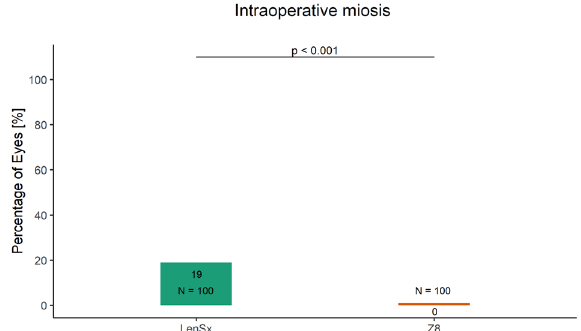
Figure 2. The proportion of eyes with intraoperative miosis in the LenSx and the Z8 laser group.